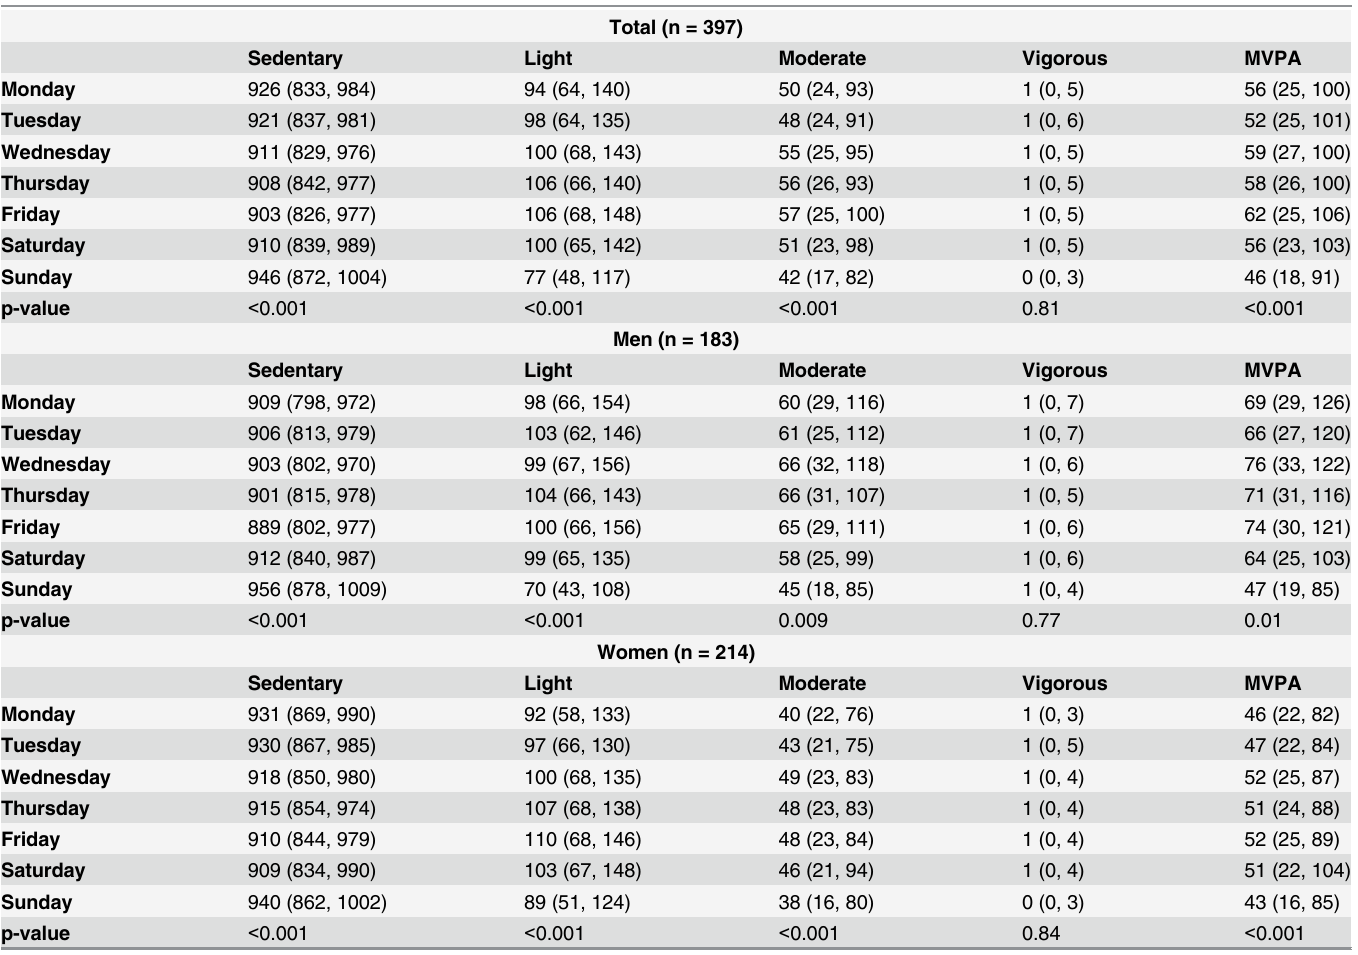
Table 3. Daily duration (minutes) of sedentary, light, moderate and vigorous